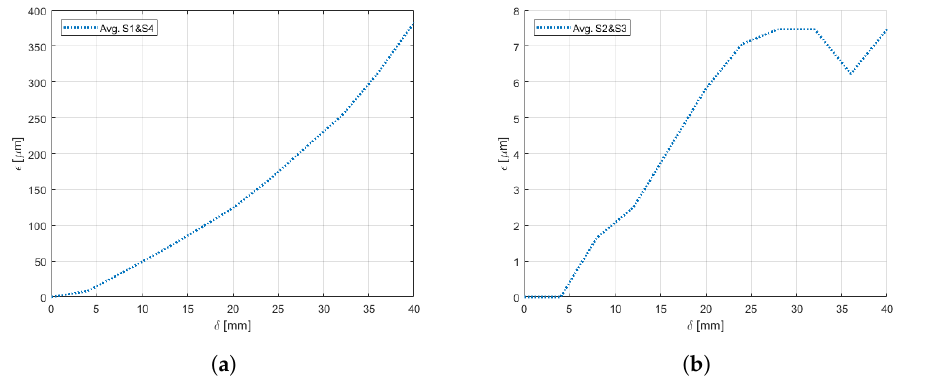
Figure 9. Strain trend in the top section of the wing through sensors ( a ) S 1 and S 4 and ( b ) S 2 and S 3, undergoing bend-down with respect to deflection due to morphing. Separate figures are used due to the large variation in scales.